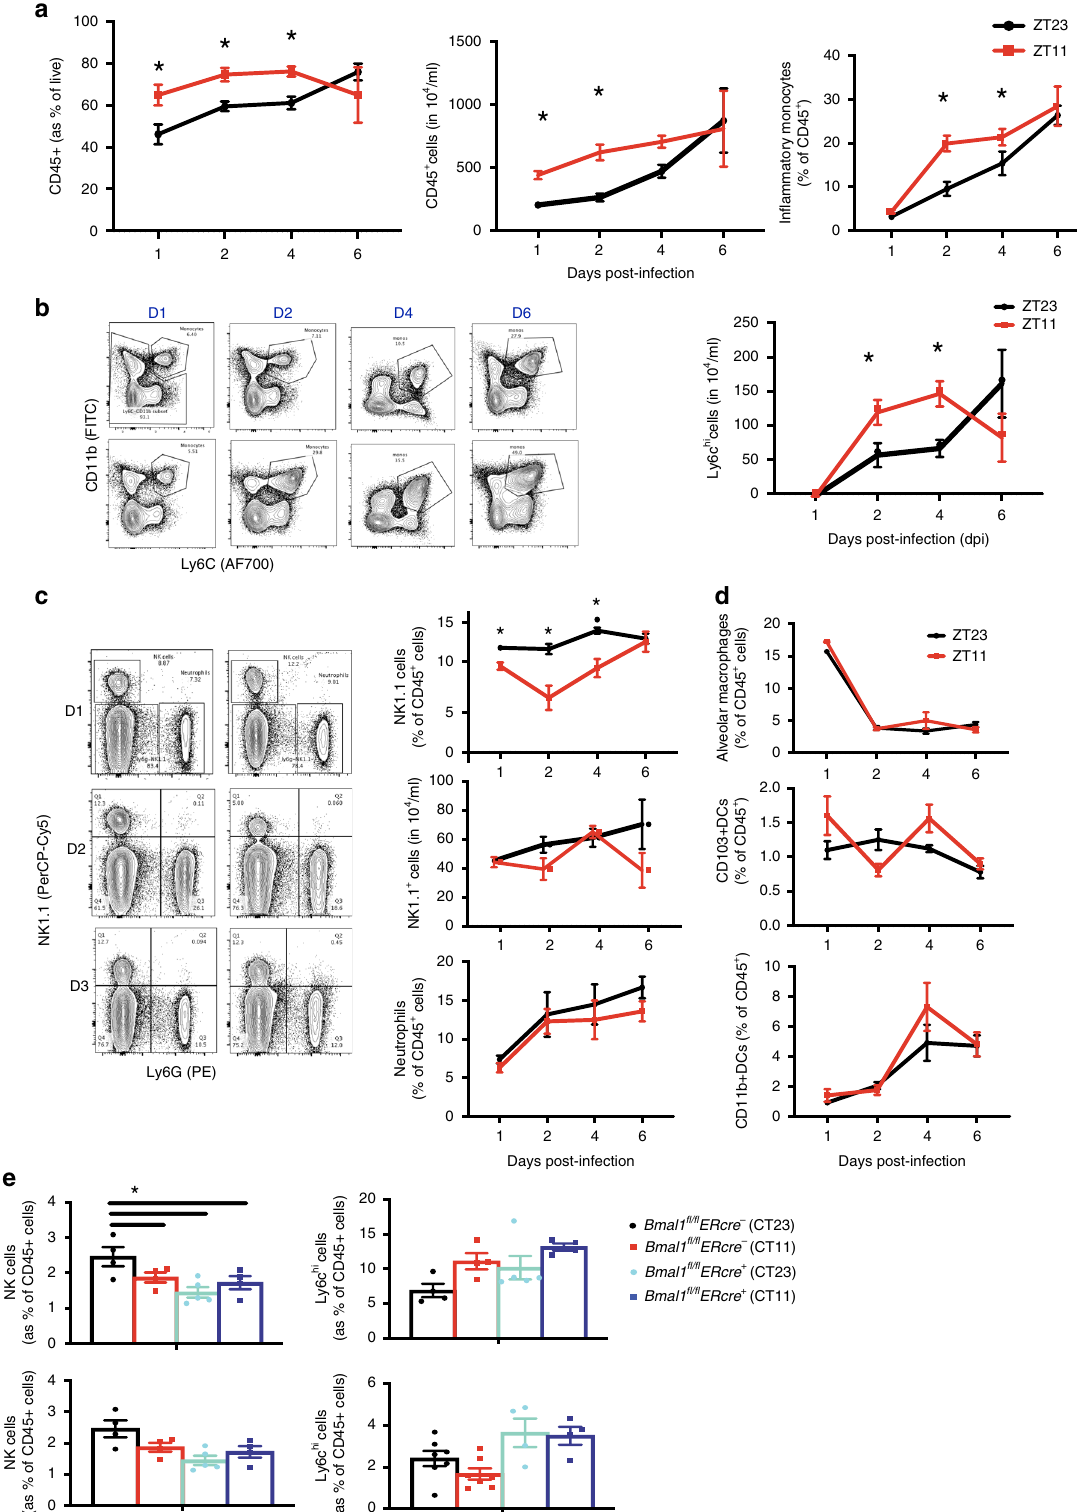
implicated in our transcriptomic pro fi ling), but has been difference in outcomes and generally had outcomes comparable employed to interrogate the effect of in fl ammatory monocytes. with the ZT11 group among WT animals that had worse out- The littermate controls maintain their circadian gating (survival comes (Fig. 6a, b). We used the LysM-CreBmal1 fl / fl which deletes of 80% in CT23 vs. 25% in CT11; p < 0.05 by Mantel – Cox log- Bmal1 in the myeloid lineage, to disrupt the clock in in fl amma- rank test; Fig. 6c). However, deletion of Bmal1 in the myeloid tory monocytes. This strategy targets the entire myeloid lineage compartment, while completely obliterating the time of day effect (including neutrophils and macrophages, the former being NATURE COMMUNICATIONS| (2019) 10:4107